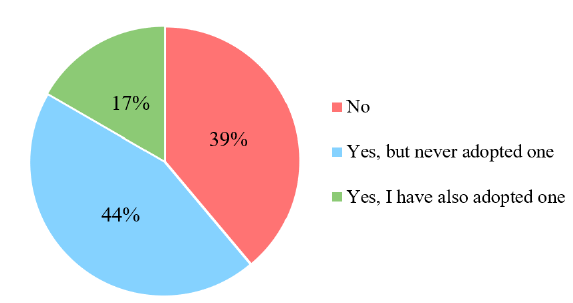
Fig. 2 . Question: “Have you ever considered adopting technological solutions?”.